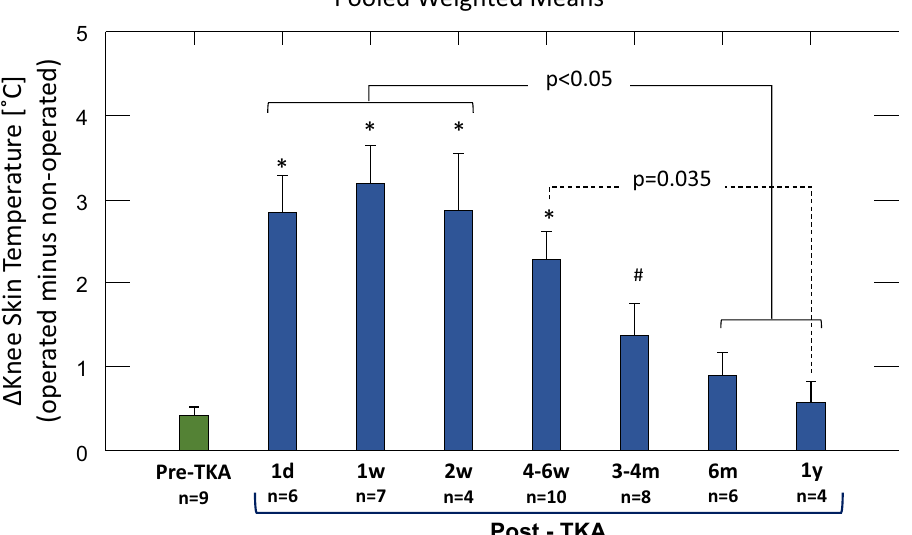
Figure 5. Knee Skin Temperature Before and After Total Knee Arthroplasty. Bar graph integrating meta- analysis results showing knee skin temperature differences in degrees Celsius before total knee arthroplasty (pre- TKA) and for each follow up time point (post-TKA) as well as the statistical results of the comparisons between these time-points. Bars = pooled weighted mean ± standard error of the mean by meta-analysis. Statistical results by 1-way ANOVA with Tukey as post-hoc test: * p < 0.005 vs Pre-TKA; # p = 0.015 vs 1 wk; TKA = total knee arthroplasty; n = number of studies included; d = day; w = week; m = months; y =